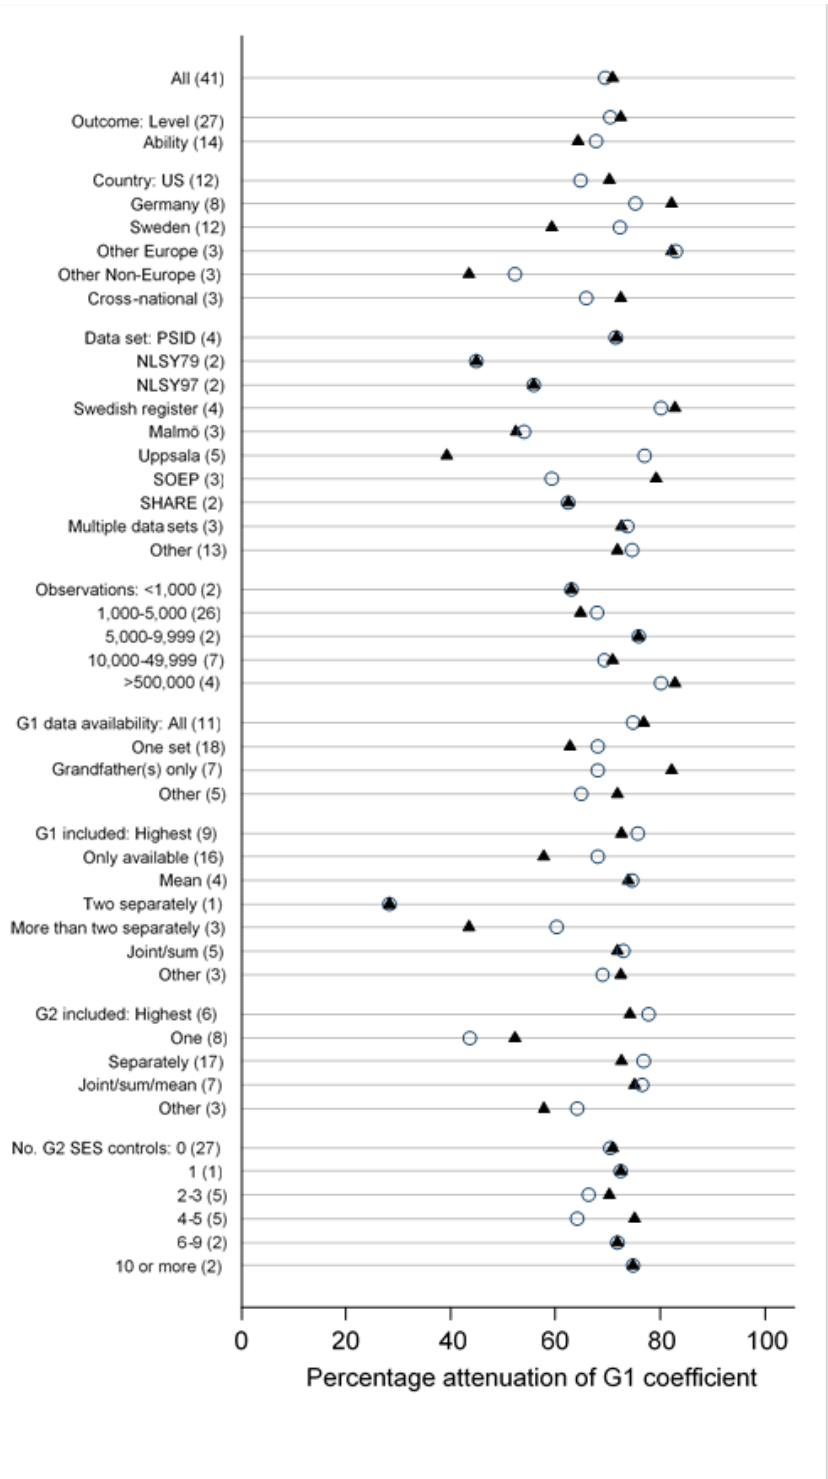
Figure 5: Attenuation in G1 coefficients from bivariate to full model: mean and median by analysis character- istics. Note: The number of observations in each category is included in